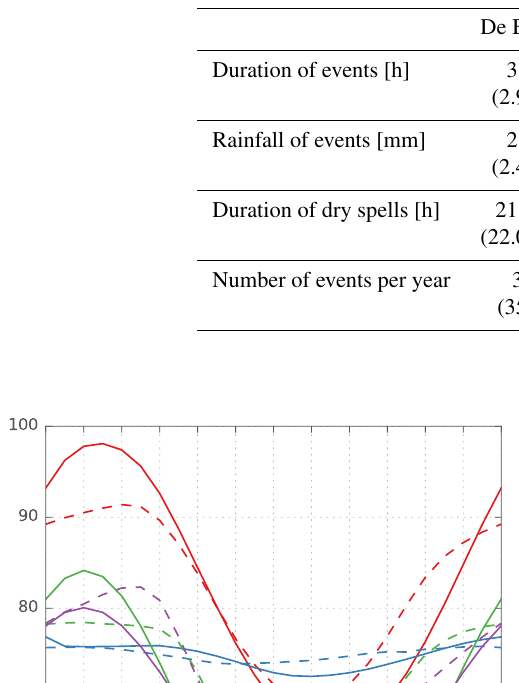
Table 7. Model performance of the precipitation cascade model (P2) evaluated for each station. For the validation period, mean values are given for some relevant characteristics of the precipitation time series. An event is defined through consecutive hours with precipitation intensity greater than 0mm h − 1 . Numbers in parentheses refer to the respective observed time series of each station.